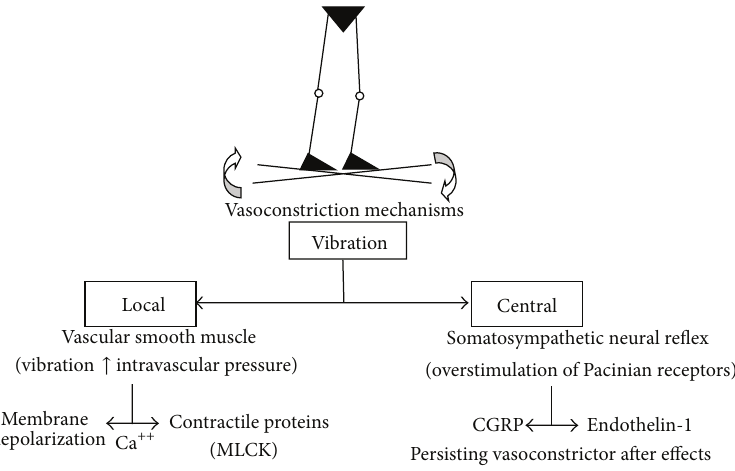
Figure 5: Putative local and central mechanisms involved in vascular smooth muscle vasoconstriction mediated by vibration stimulation (see text for